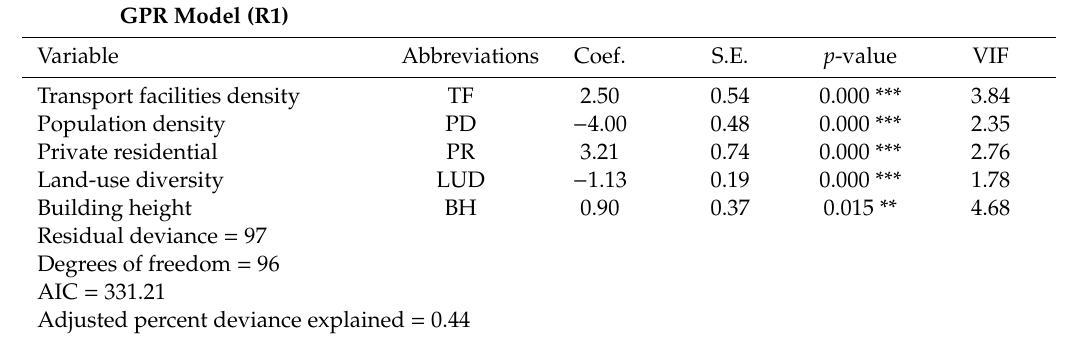
Table 3. Global Poisson regression (GPR) results.